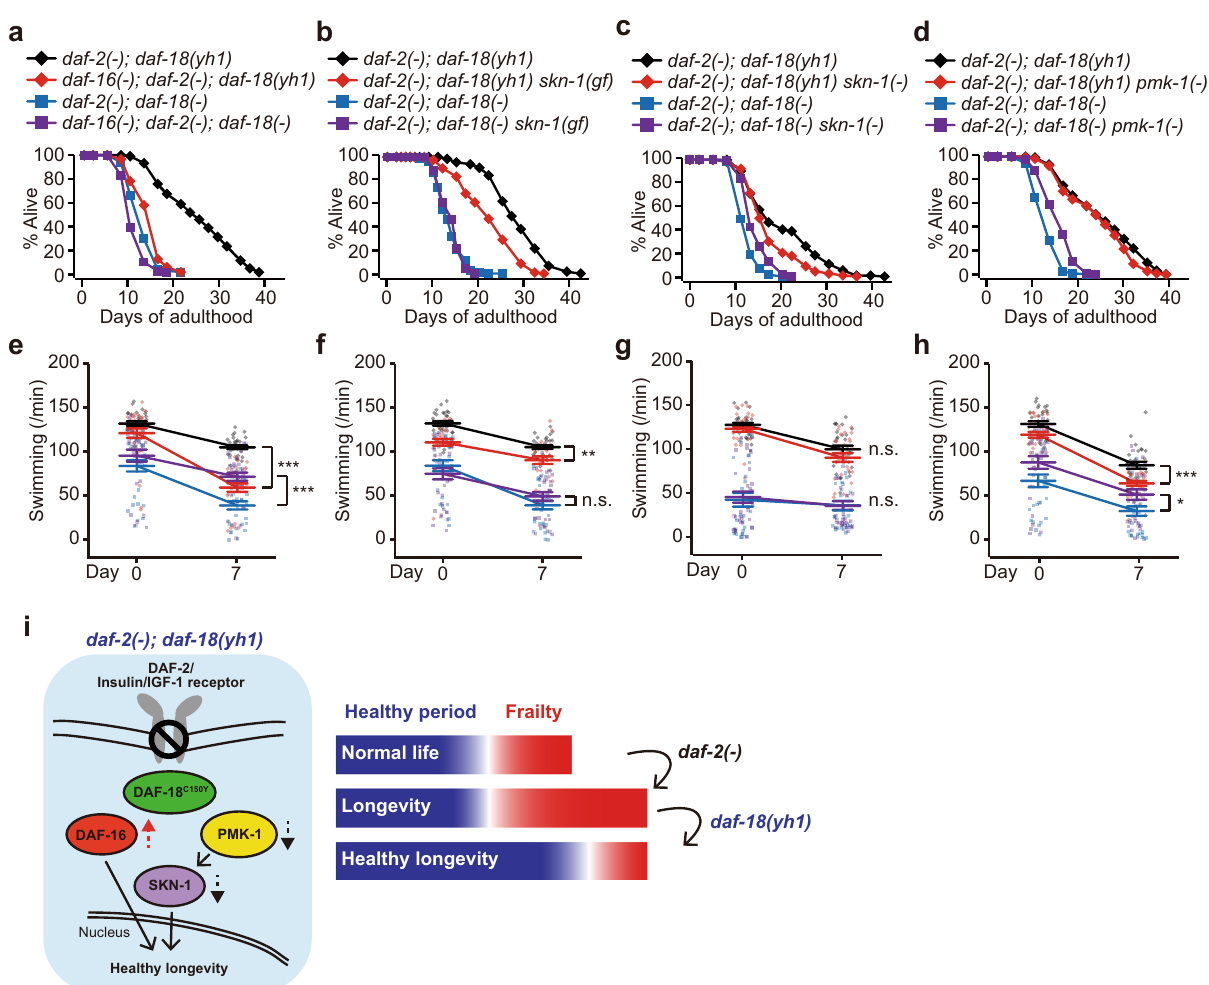
Fig. 6 daf-18(yh1) exerts healthy longevity in daf-2( − ) animals by maintaining the activity of DAF-16/FOXO while reducing that of SKN-1/NRF2. a – d Effects of daf-16(RNAi) [ daf-16( − ) ] ( a ), skn-1(lax188) [ skn-1(gf) ] ( b ), skn-1(zj15) [ skn-1( − ) ] ( c ), and pmk-1(RNAi) [ pmk-1( − ) ] ( d ) on the lifespan of daf- 2(e1370); daf-18(yh1) [ daf-2( − ); daf-18(yh1) ] and daf-2( − ); daf-18(nr2037) [ daf-18( − ) ] animals ( n ≥ 240 for each condition). All the lifespan assays were performed at least twice independently. e – h Effects of daf-16(mu86) ( e ), skn-1(gf) ( f ), skn-1( − ) ( g ), and pmk-1( − ) ( h ) on the swimming rate (motility) of daf-2( − ); daf-18(yh1) and daf-2( − ); daf-18( − ) animals at day 0 and day 7 adulthoods ( n = 30 for each condition, from three independent trials). See Supplementary Fig. 10c for the effects of skn-1( − ) on the lifespan of daf-2( − ) and wild-type (WT) animals. See Supplementary Fig. 10e, f for the requirement of PMK-1 for the decreased PA14 susceptibility of daf-2( − ) and daf-2( − ); daf-18(yh1) worms and for the normal survival of WT on PA14. We found that skn-1( − ) did not affect either the motility of daf-2( − ); daf-18( − ) or that of daf-2( − ); daf-18(yh1) worms in ( g ), and this may be due to the weak nature of the zj15 allele, which needs to be tested in various other genetic backgrounds in future research. Error bars represent the standard error of the mean (s.e.m., * p < 0.05, ** p < 0.01, *** p < 0.001, n.s.: not signi fi cant, two-tailed Student ’ s t test). i A schematic showing that daf-18(yh1) retains partial transcriptional activity of DAF-16/FOXO while suppressing the hyperactivation of PMK-1/p38 MAPK and SKN-1/NRF2 in daf-2( − ) mutant animals, which contributes to healthy longevity. Thus, daf-18(yh1) increases healthy periods, while decreasing the time of frailty caused by longevity-promoting daf-2( − ) mutations. A dotted, upward arrow indicates partial activity maintenance, and dotted, downward arrows indicate suppression of hyperactivation. See Supplementary Dataset 2 and 4 for additional repeats and statistical analysis for the lifespan and health span assay data shown in this fi gure. See also Source Data for data points used for the derivation of similarly to daf-18( − ) (Fig. 5a). Thus, the nuclear localization status of DAF-16 does not appear to always correlate with target gene expression levels. One possible interpretation for this is that target gene expression of DAF-16/FOXO is affected by the sur- rounding density of cofactors or inhibitors of the DAF-16/FOXO. In addition, DAF-16-binding elements (DBEs) associated with direct targets of DAF-16/FOXO and DAF-16-associated elements (DAEs) associated with indirect targets may be differentially regulated by daf-18( − ) and daf-18(yh1) in daf-2( − ) mutants. Further research is required to test these possibilities for better understating of regulation of DAF-16/FOXO by DAF-18/PTEN.